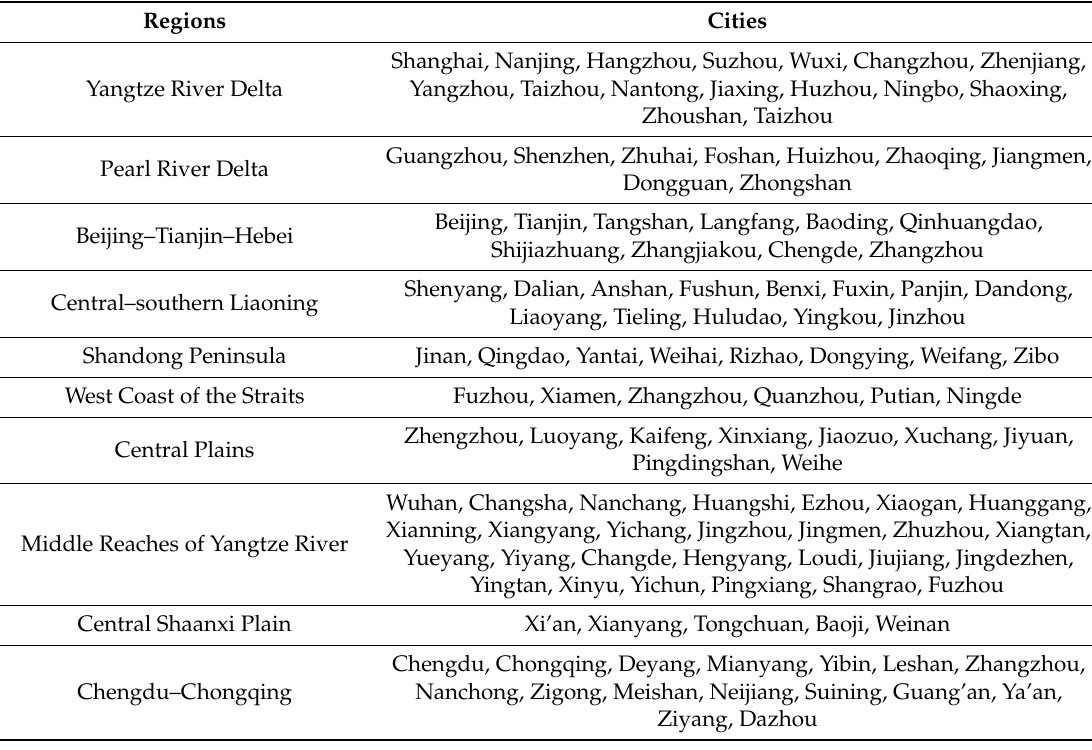
Table 2. Definition of China’s largest urban